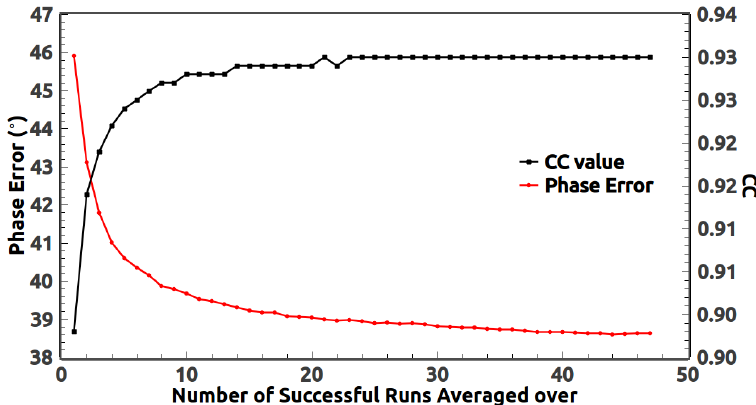
Figure 6. The phase error and CC value after averaging over those successful runs of 4NF2.